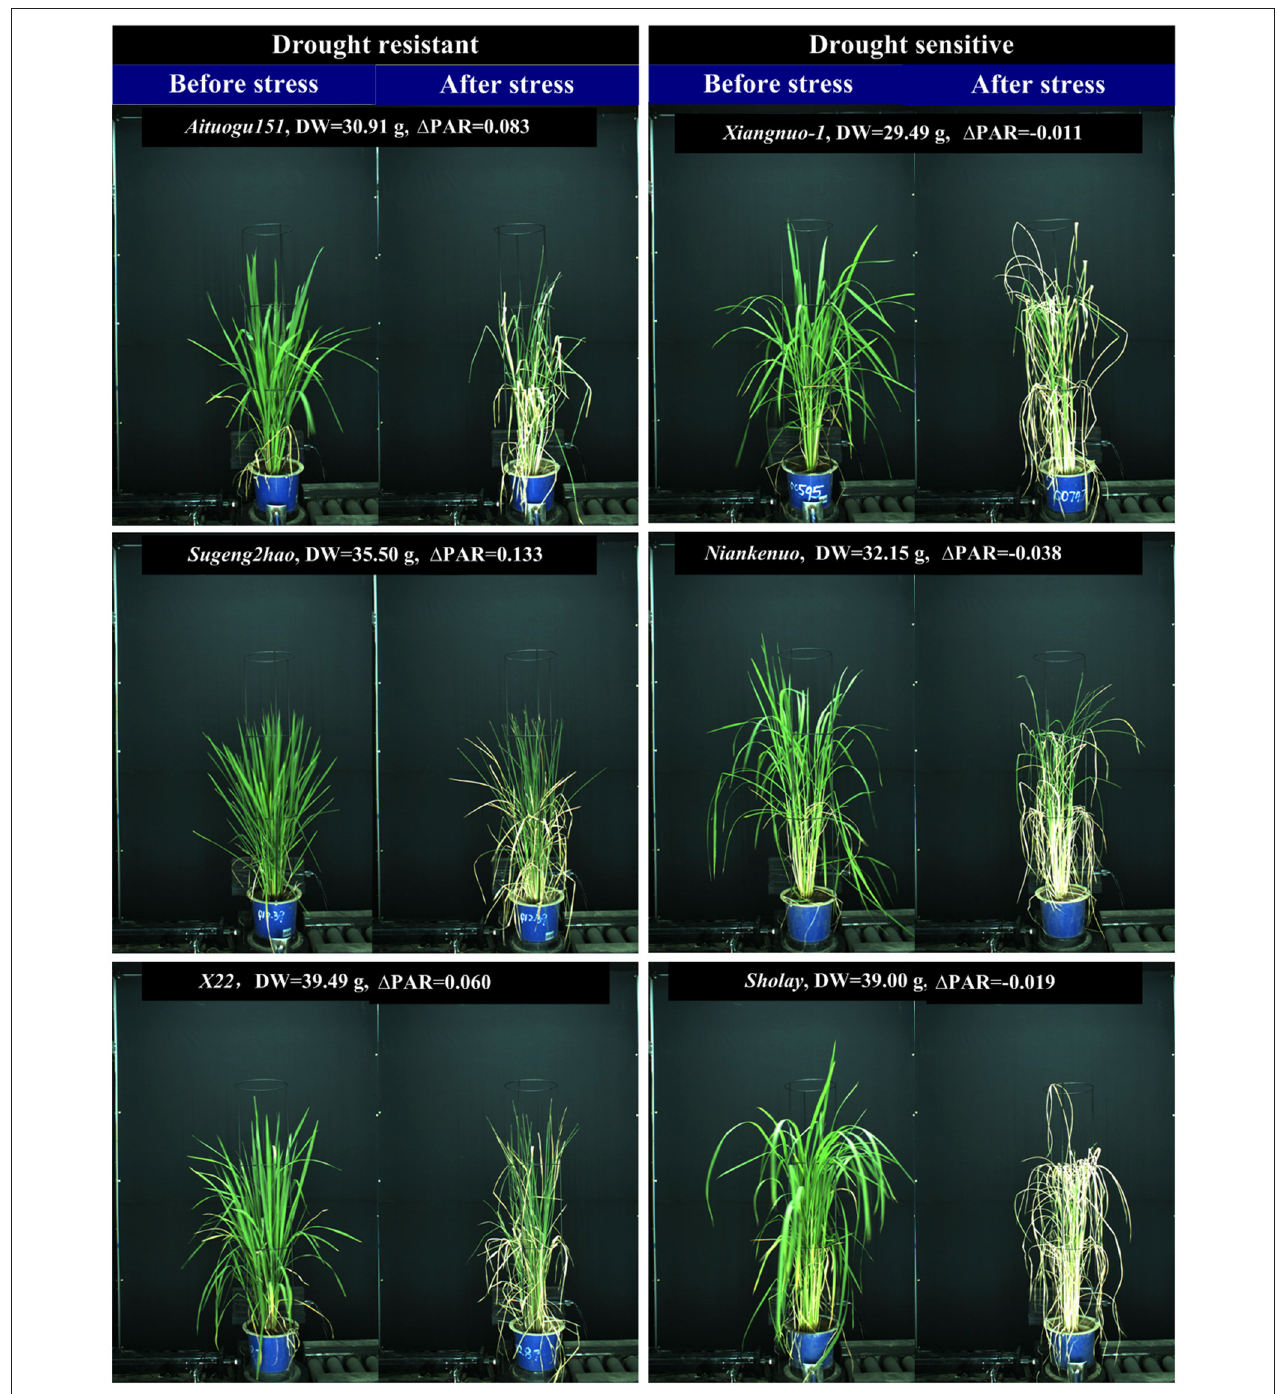
FIGURE 5 | Accessions with similar plant dry weight may have different drought tolerance. 1 PAR was PAR change, and DW was plant dry weight after stress (g). resistant and drought sensitive accessions decreased as the drought stress intensified and increased after rehydration. However, the amplitude of variation in GPAR was much smaller for drought resistant accessions than drought sensitive